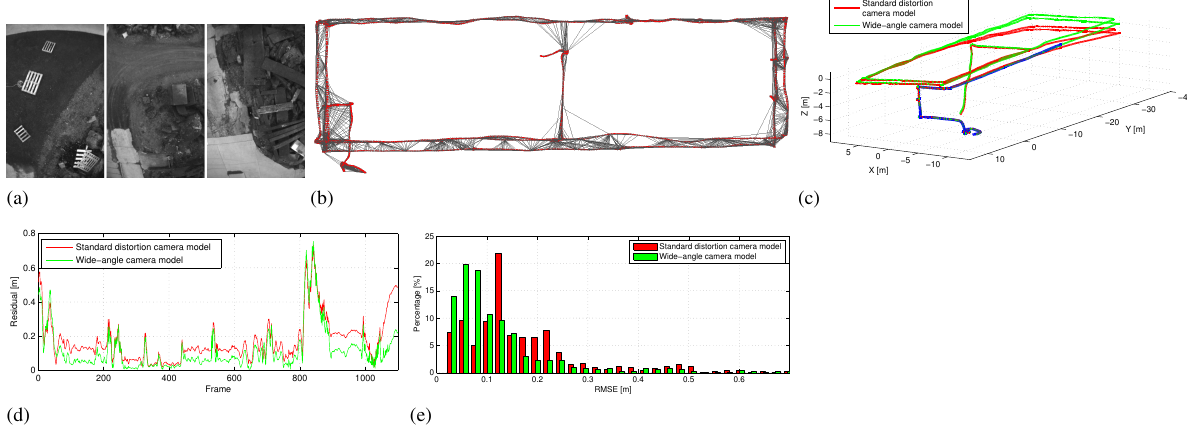
Figure 3: Rubble 2 data-set: Low-resolution, distorted MAV image sequence (a), the reconstructed trajectory with loop-closure con- nections (b), the ground-truth and reconstructed trajectory (c), and residuals of the reconstruction results w.r.t. the ground-truth